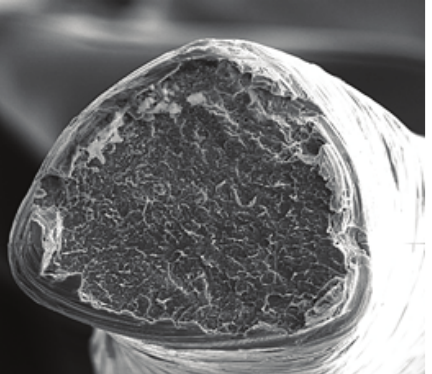
Figure 2: Fractographic analysis of the fracture surface of a Wizard Navigator instrument after cyclic fatigue testing (magnification 400x).